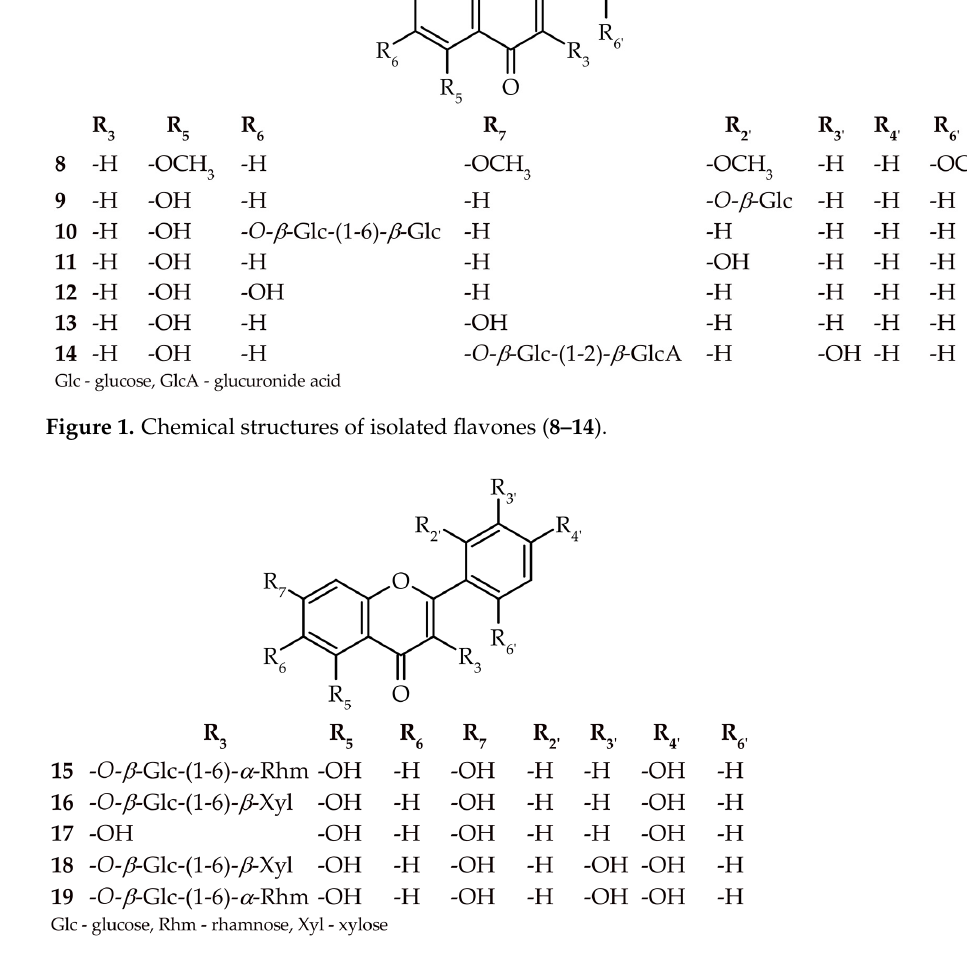
Figure 2. Chemical structures of the isolated flavonols ( 15–19 ).